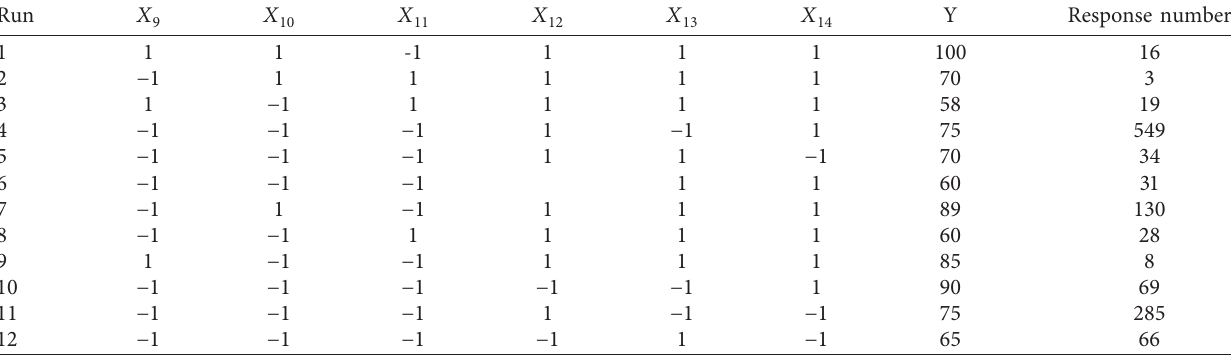
Table 18: One replicate for Example 6.